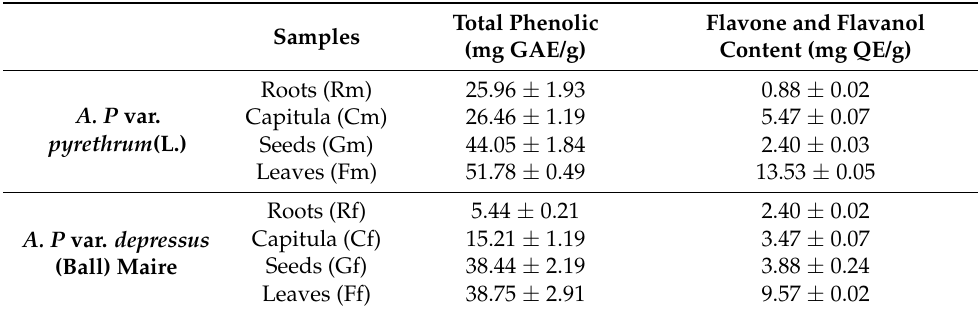
Table 4. Total phenolic, flavone, and flavonol contents of different extracts of A. P var. pyrethrum (L.) and A. P var. depressus (Ball) Maire.